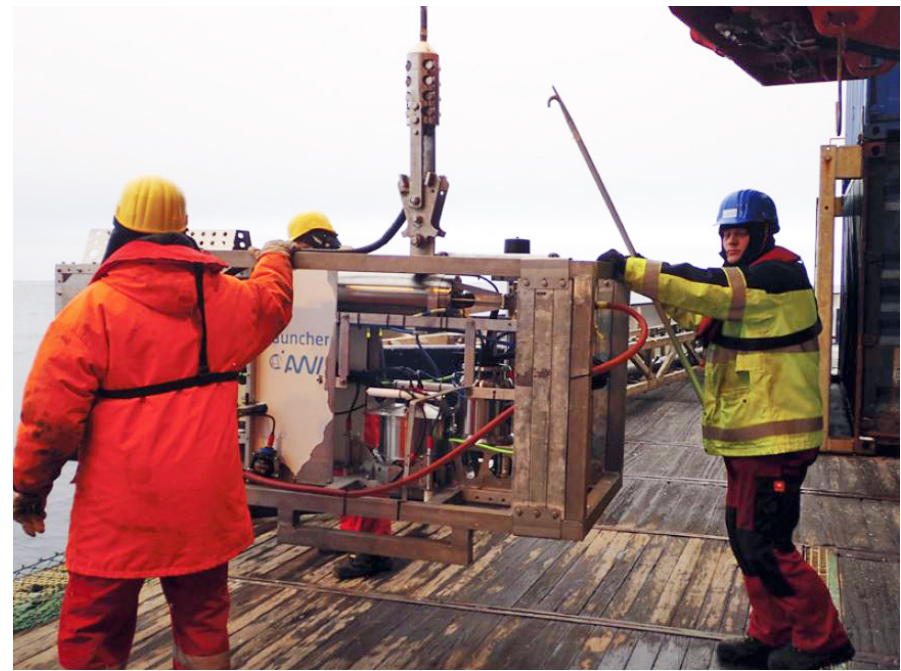
Figure 1. The Ocean Floor Observation and Bathymetry System (OFOBS) of the Alfred Wegener Institute (AWI), Helmholtz Centre for Polar and Marine Research, deployed from the RV Polarstern during cruise PS118 in the waters east of the Antarctic Peninsula and on the flanks of the Powell Basin (February–April